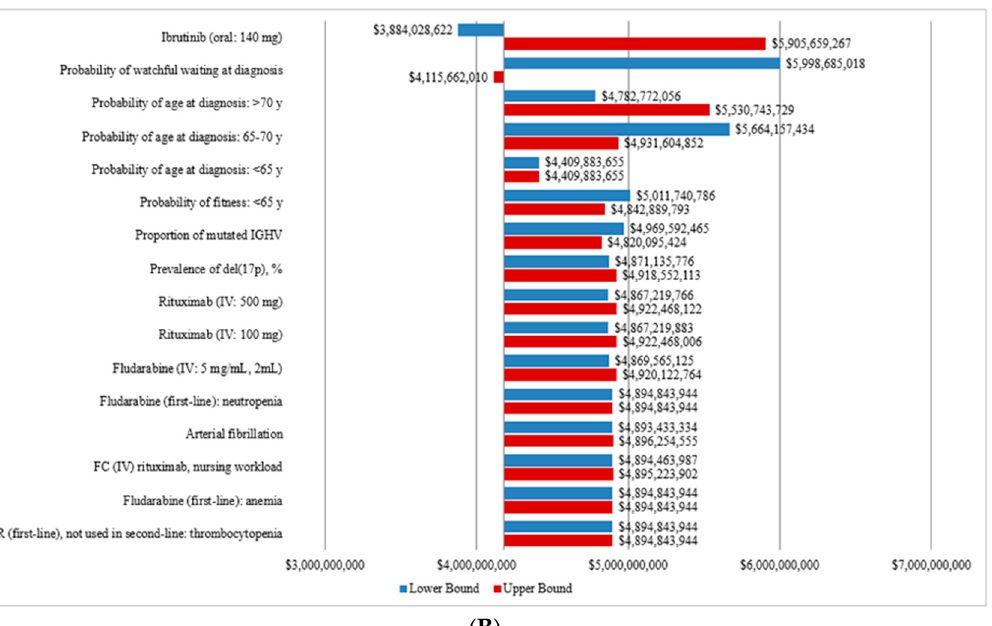
Figure 4. Sensitivity analysis of the total annual costs a of CLL for the CIT and the OTT scenarios. ( A ) Tornado diagram for the one-way sensitivity analysis of the total annual cost for the CIT scenario. ( B ) Tornado diagram for the one-way sensitivity analysis of the total annual cost for OTT scenario. CIT, chemoimmunotherapy; CLL, chronic lymphocytic leukemia; del(17p), deletion at chromosome 17p targeting the TP53 gene; FC, fludarabine, cyclophosphamide; FR, fludarabine and rituximab; IGHV, immunoglobulin heavy-chain variable; IV, intravenous; OTT, oral targeted therapy. a All costs are shown in 2019 Canadian dollars.